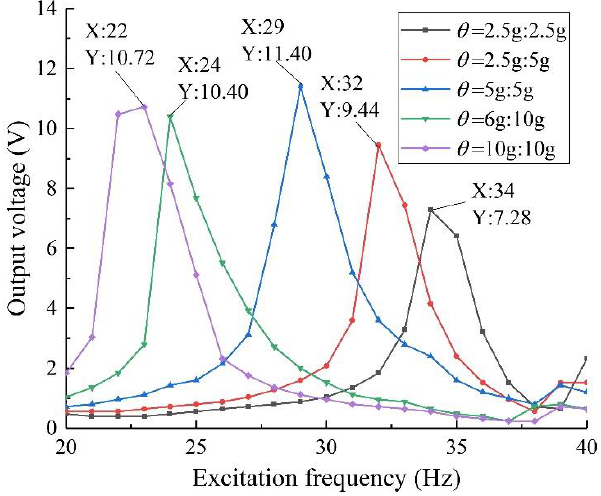
Figure 15. Output voltage with different mass ratios.